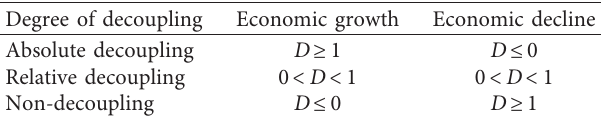
Table 3: Division of the degree of decoupling based on the values of the decoupling indicator of material consumption or CO 2 emis- sions ( D m or D e